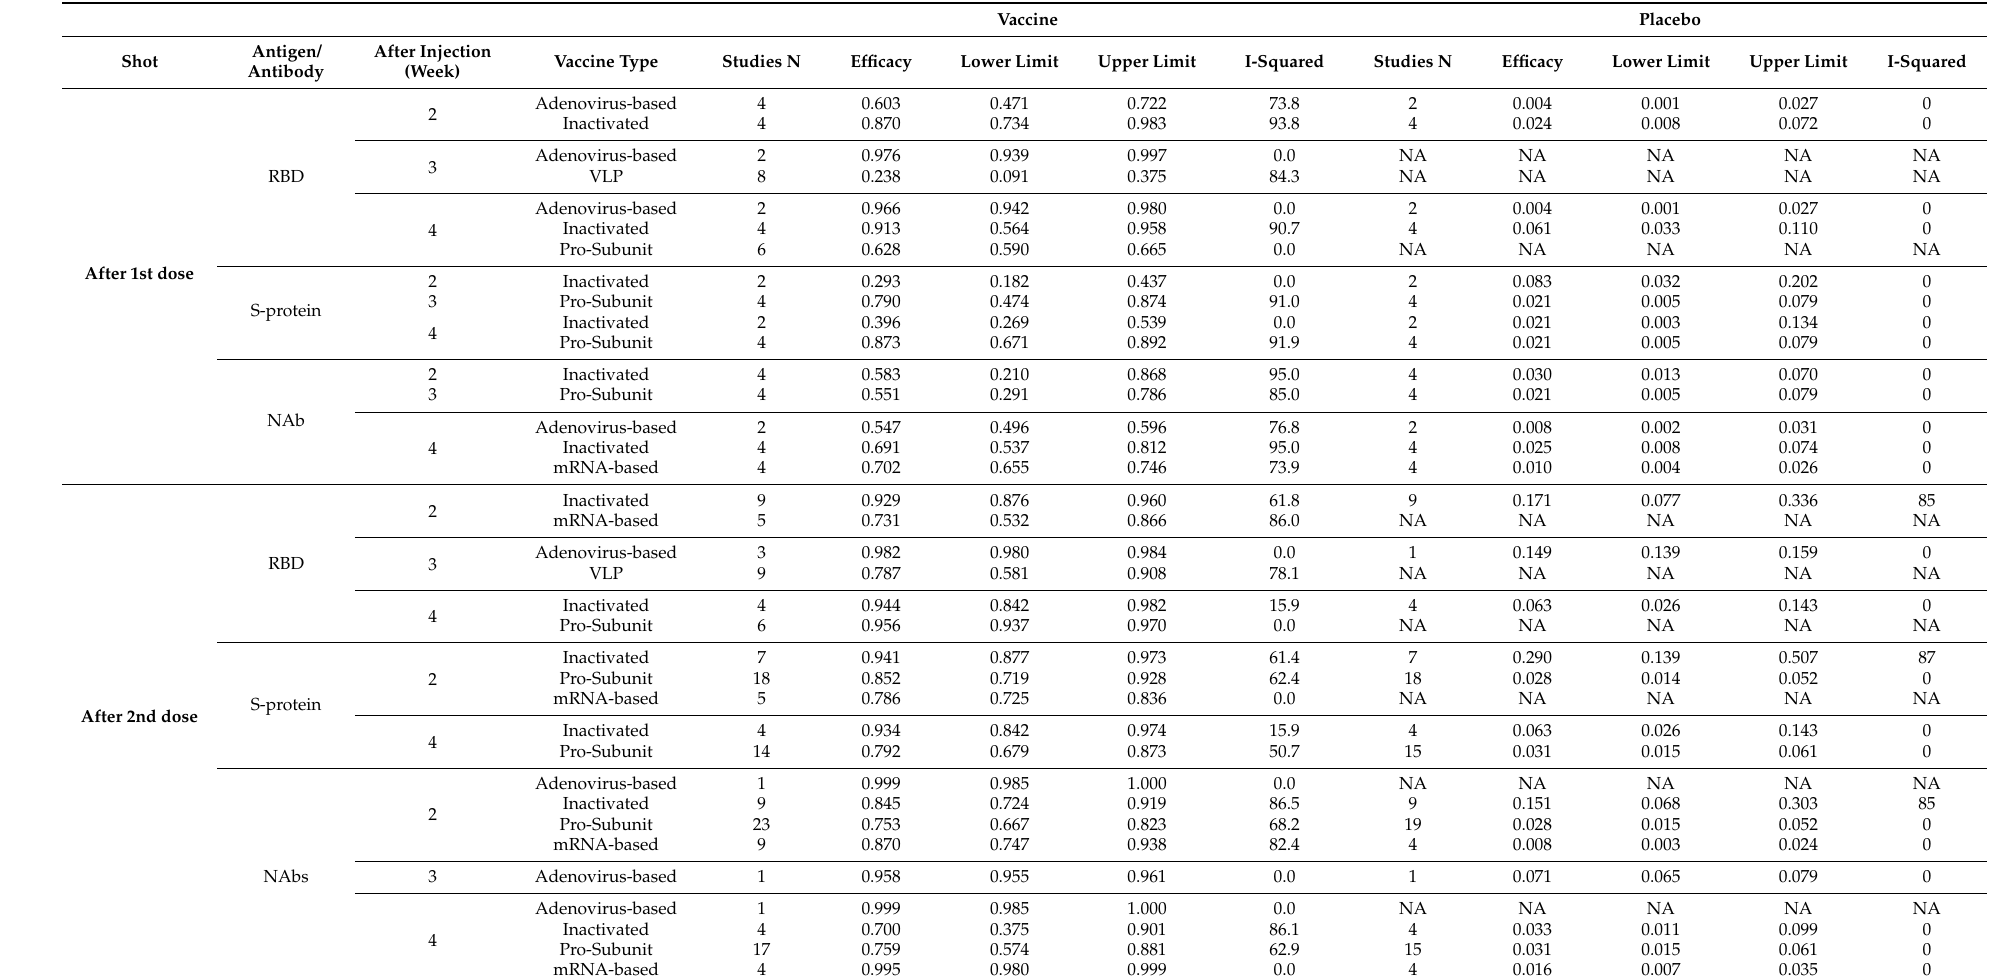
Table 3. Efficacy of different COVID-19 vaccines after the first and second doses.